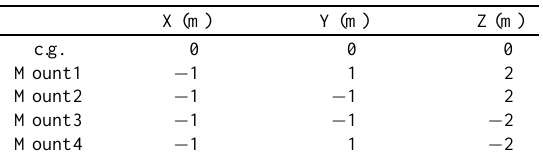
Fig. 3. Vertical force transmission at mount 1-infinite plate with light fluid loading under the unit vertical force excitation ( F x ) at c.g. of rigid body. Table 1 Mounting locations of